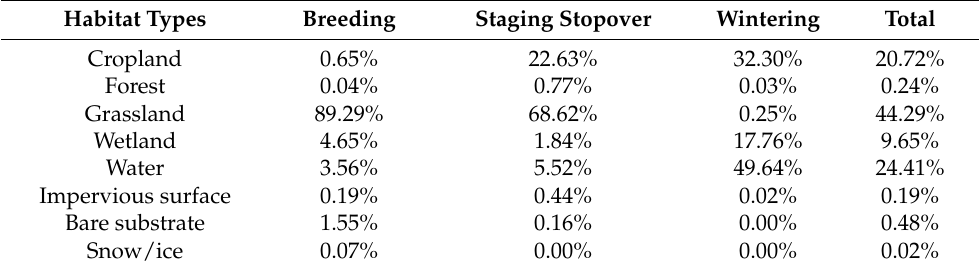
Figure 3. Mapping of white-naped cranes ( Antigone vipio ) migration corridors, based on Kernel Density Estimation summarization of tracking data from 39 tracked individuals throughout the annual cycle summed over two years. Orange to red colour indicate highest intensity of use, green to yellow lowest. Right side of the figure shows time spent in each latitude zone. Summary mean seasonal habitat use of Mongolian–Chinese white-naped cranes Antigone vipio